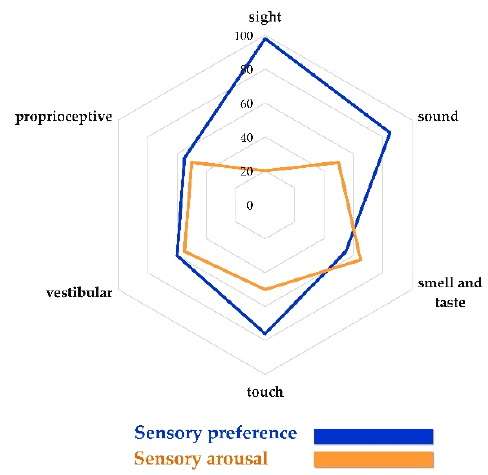
Figure 1. Radar chart of TSPA interpretation.